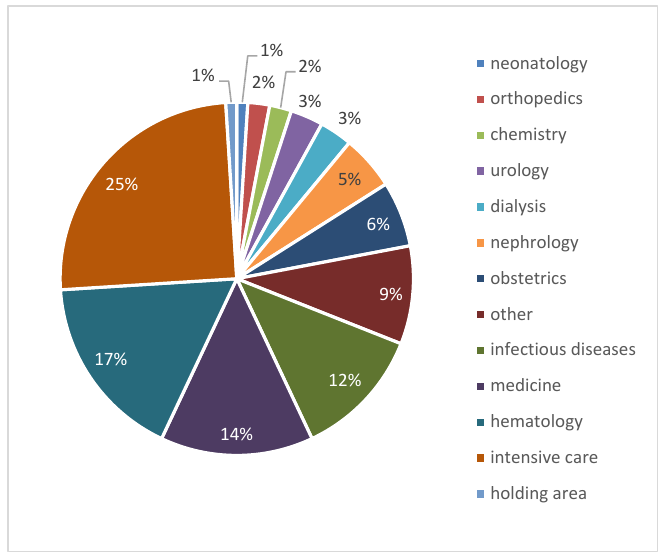
Figure 6. Distribution of nosocomial cases as a function of hospital department (from the database described in Section 2.2). The highest number of patients contracting infections inside the hospital occurs